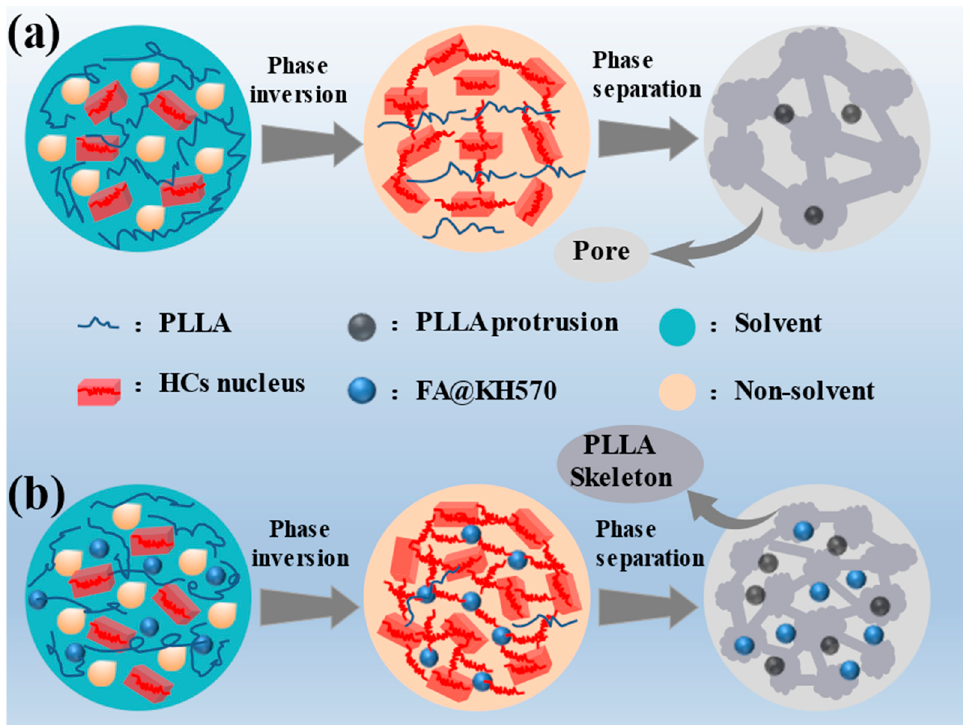
Figure 5. Mechanism diagram of the growth of hierarchical structures for ( a ) pure PLLA and ( b ) PLLA/FA@KH570 composites. ( b ) PLLA/FA@KH570